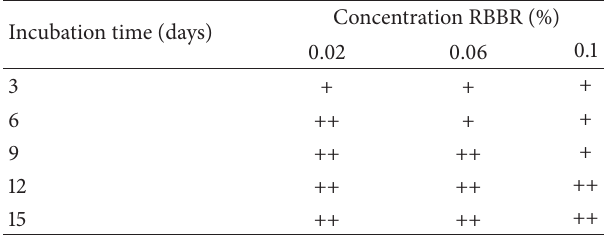
Table 4: Decolourisation of RBBR on agar plate by M. cladophyllus UMAS MS8 at 28 ∘ C.